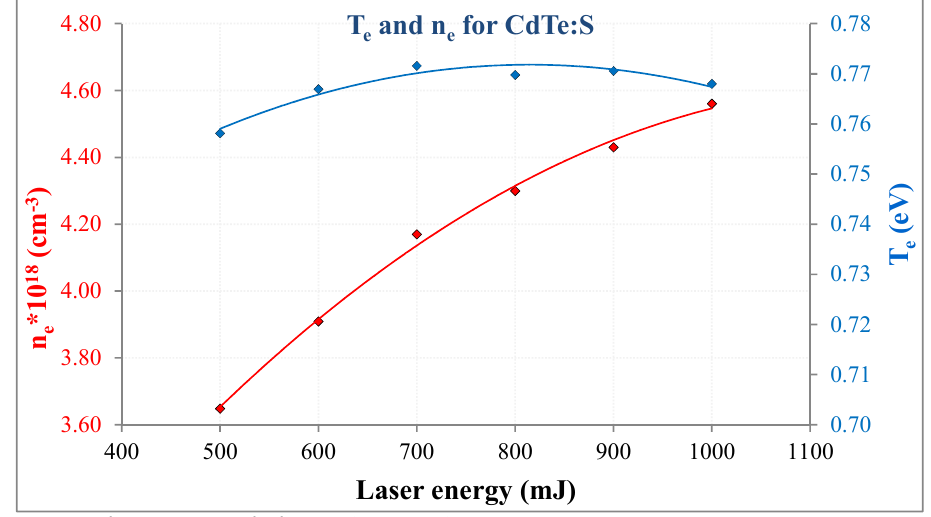
) and (n ) versus the laser energy for e e